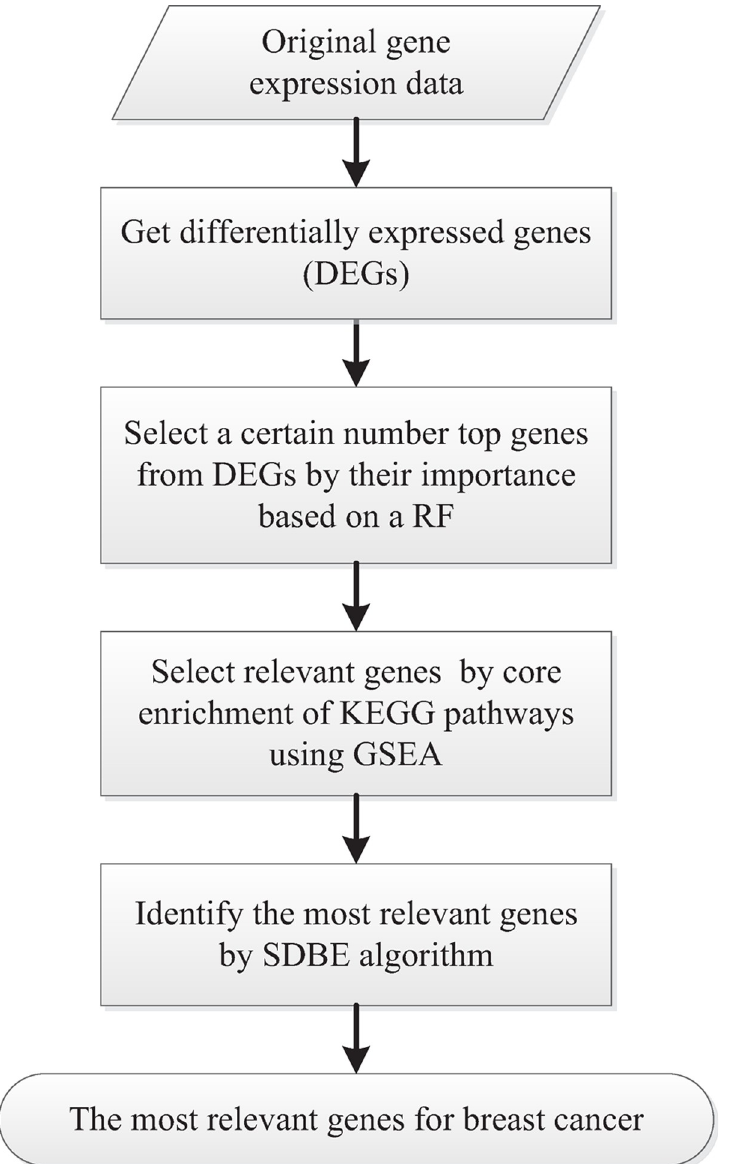
Fig 2. Gene selection procedure in the GSEA–SDBE